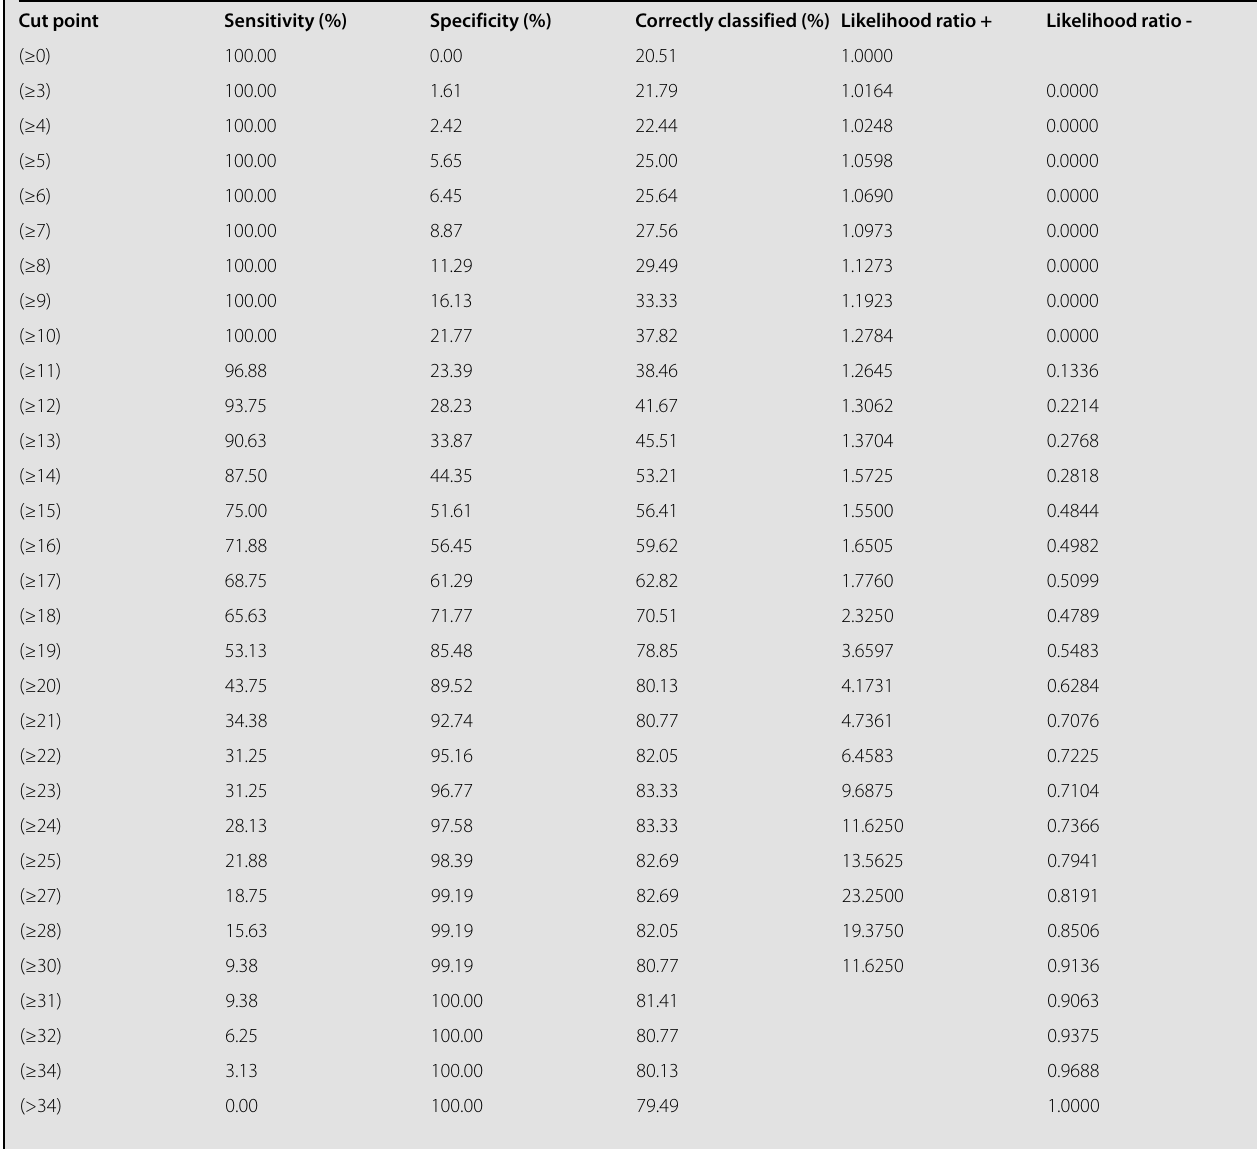
Table 3. Cut-off points of BDI and corresponding sensitivity and specificity to predict suicidal ideation 72 hours after HIV diagnosis Cut